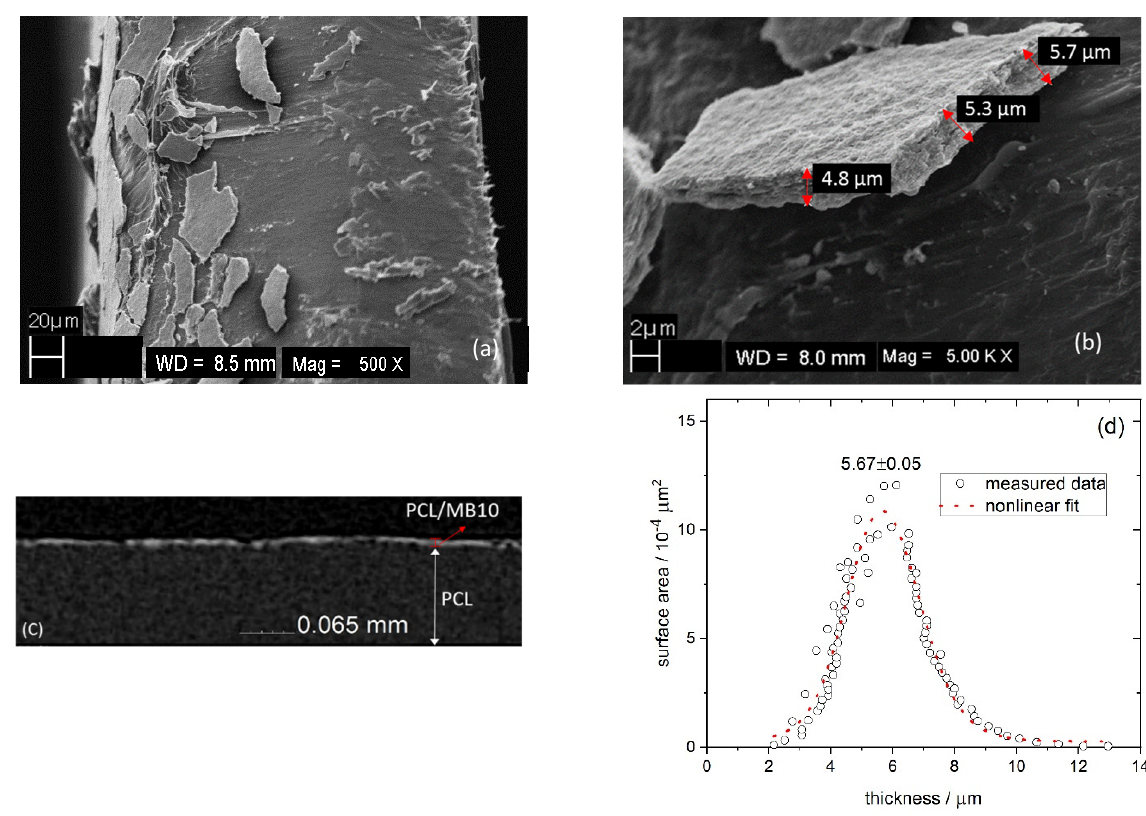
Figure 1. SEM and X-ray tomography images and the film thickness distribution of PCL/MB10 composite. The sections perpendicular to the surface by SEM ( a , b ) and an image of cross-section obtained by X-ray tomography ( c ), and the statistical distribution of the thickness values of the composite film ( d ). The most frequent thickness was estimated by the nonlinear fitting of the data using an asymmetric double Sigmoidal function (dotted line) using Origin Lab software.